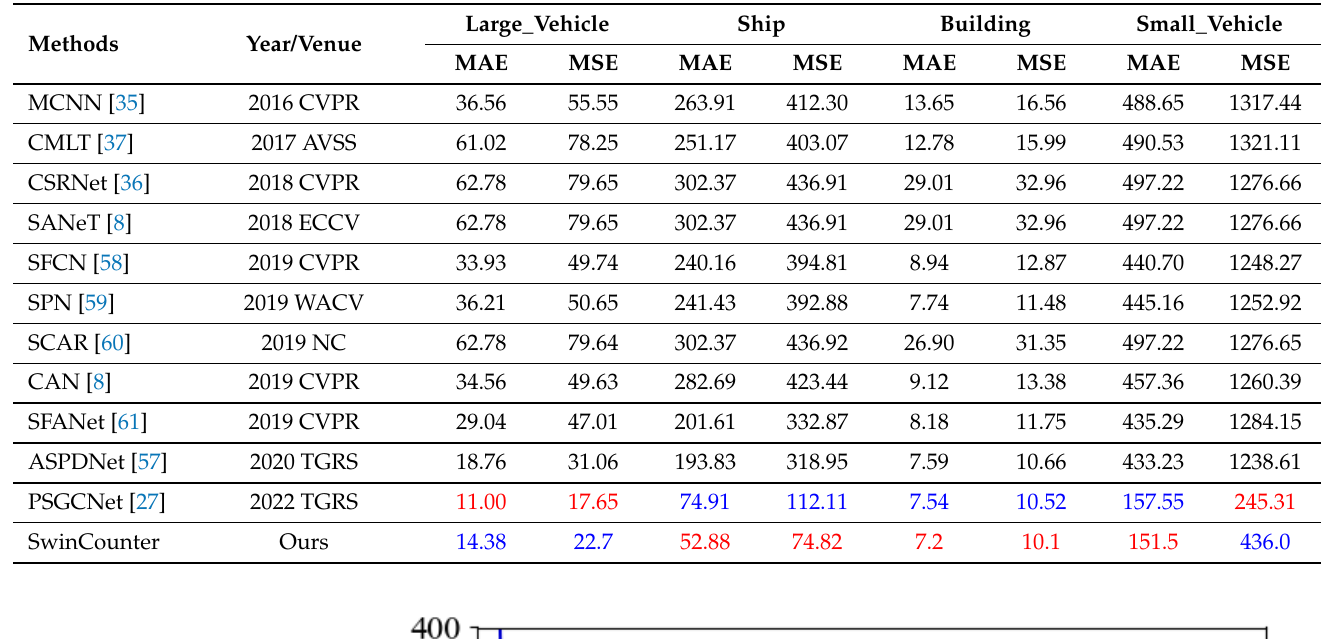
Table 2. Comparing with other state-of-the-art methods, the Large-vehicle and Ship sub datasets of the RSOC dataset are compared, and MAE and MSE are selected as evaluation metrics. the best- performing method is marked in red, and the second-best performing method is marked in blue.